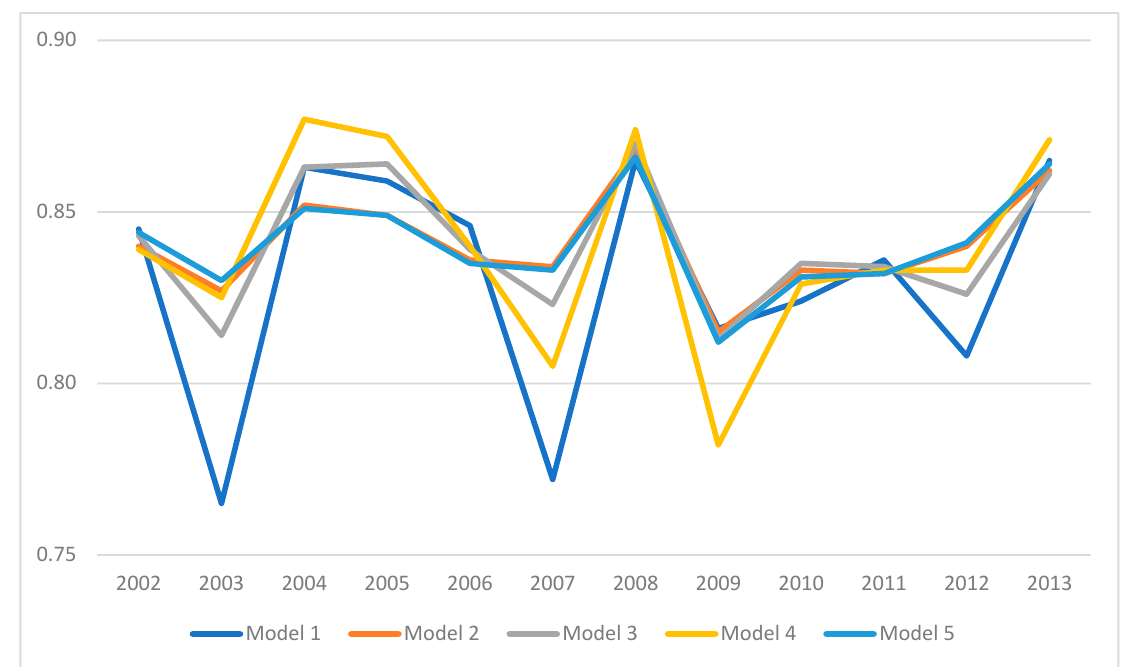
Figure 3. Average annual technical efficiency (%) estimated for each model. Source: authors’ calculations.